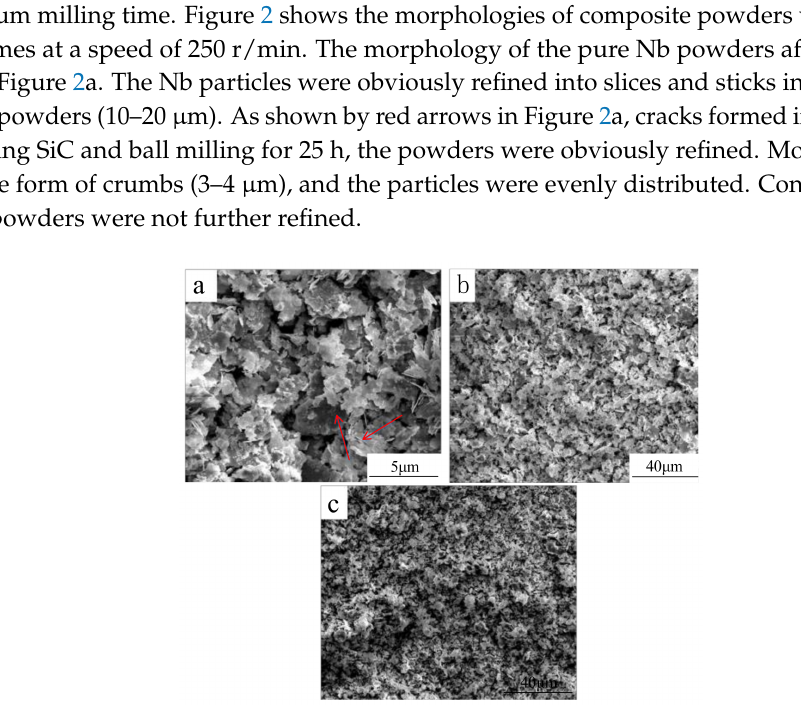
Figure 2. Scanning electron microscope micrographs of Nb/SiC composite powders ball milled for ( a ) 20 h; ( b ) 25 h; ( c ) 30